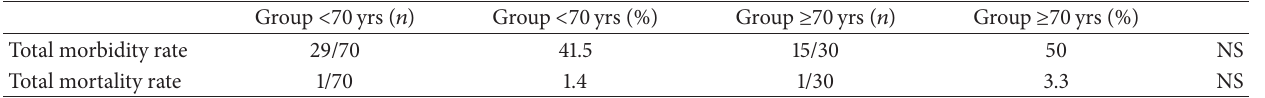
Table 3: Morbidity and mortality results between the two groups.